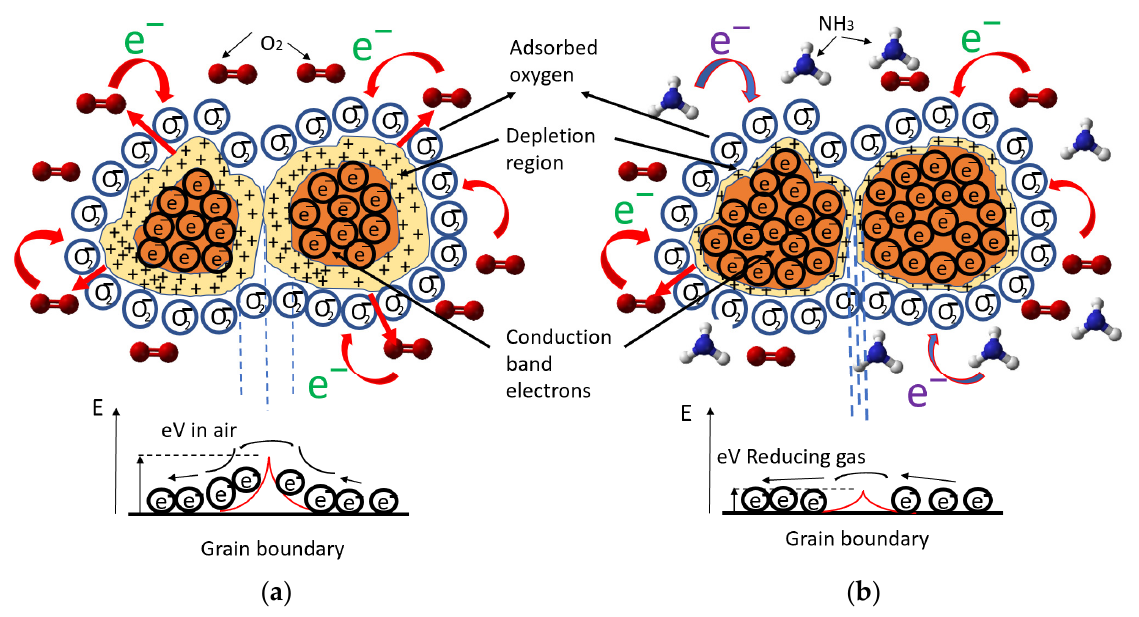
Figure 5. The scheme for physisorption under reducing gas of ( a ) air and ( b ) NH 3 .